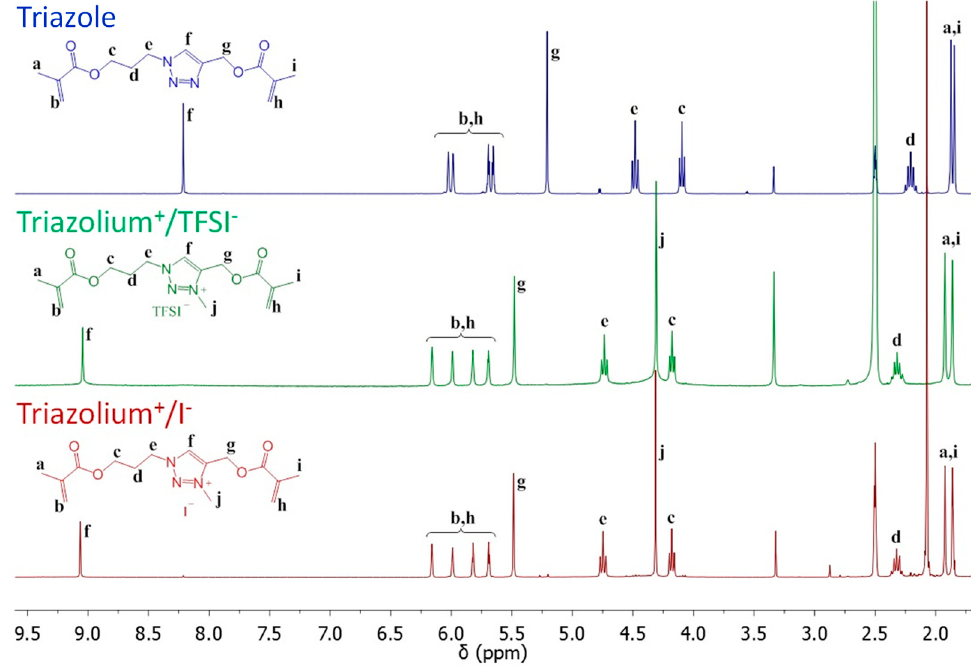
Figure 3. 1 H NMR spectrum in DMSO-d 6 of triazole (on the top in blue), triazolium + / TFSI − (on the middle in green) and Triazolium + / I − (on the bottom in red) crosslinking nodes.